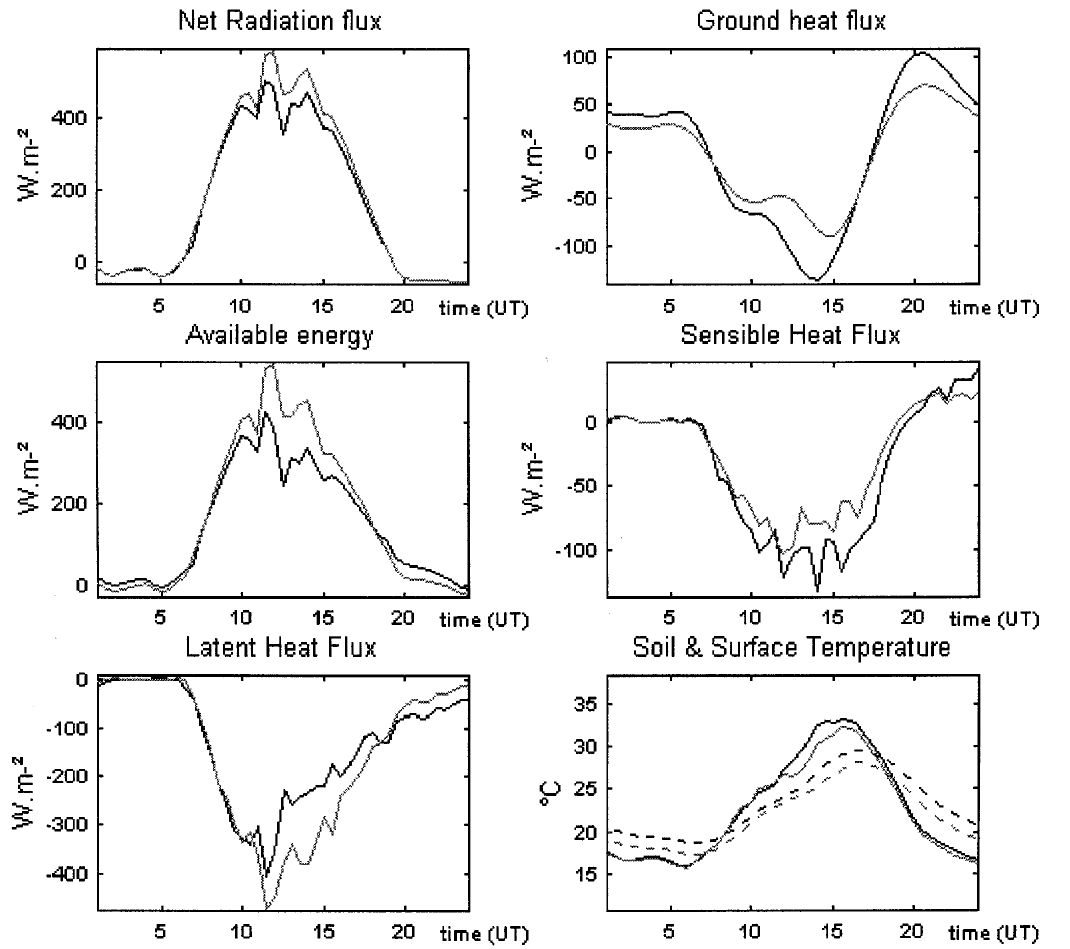
Fig. 15. An example of energy balance for the two fields, CT plot ( black ) line and RT plot ( grey ) for 25 July (DOY 205). Net radiation flux and ground heat flux plotted top - left and top - right respectively; the available energy and the sensible heat flux plotted middle - left and